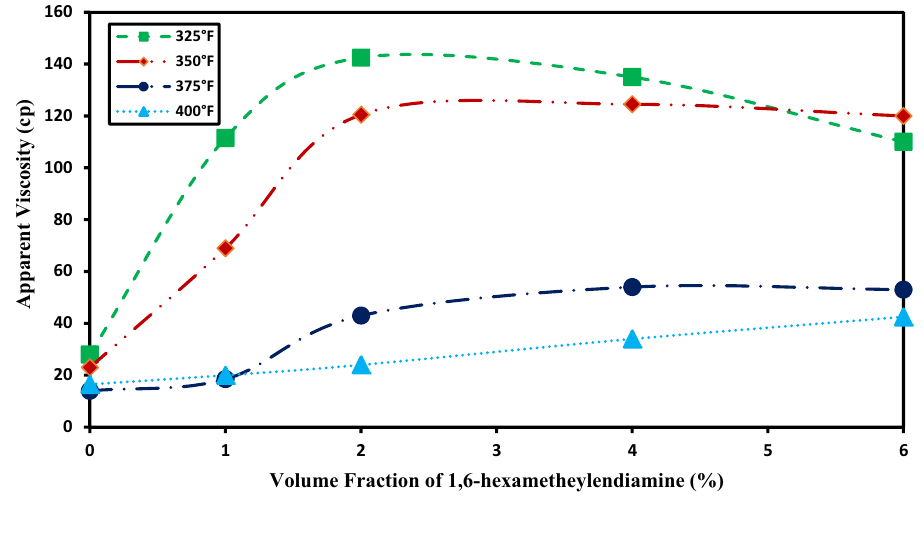
Fig. 9 Effect of the combination of 1,6-hexamethylenediamine and PAC on apparent viscosity